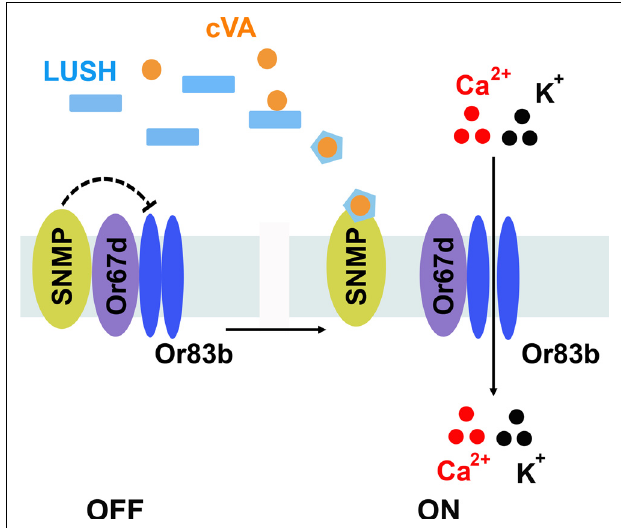
FIGURE 3 | Model for pheromone detection. The extracellular receptor LUSH binds cVA pheromone and undergoes an activating conformational shift. Activated LUSH binds SNMP and relieves SNMP-mediated inhibition of the Or67d/Or83b receptor complex, allowing cations to enter the